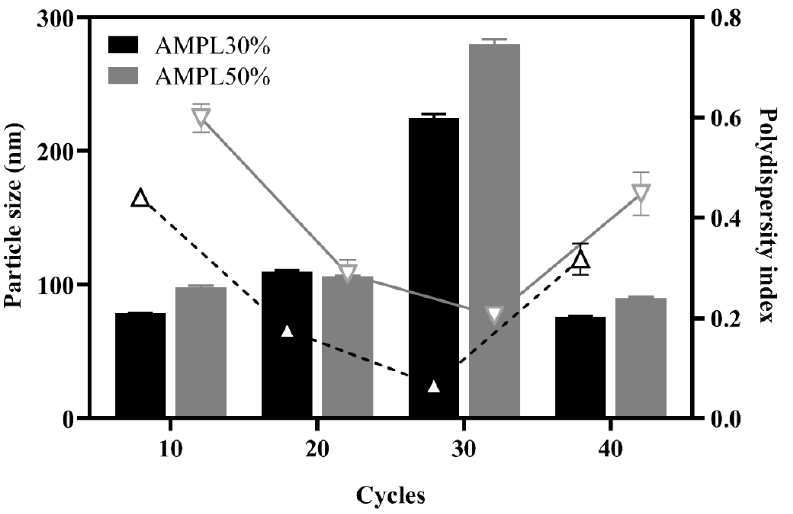
Figure 2. Effects of different amplitudes (AMPLs) of ultrasonication and different cycles of high- pressure homogenization on the particle size and size distribution. Column: particle size (nm); line: polydispersity index. Each point represents the mean ± SD. Error bars represent the standard deviation ( n = 3).